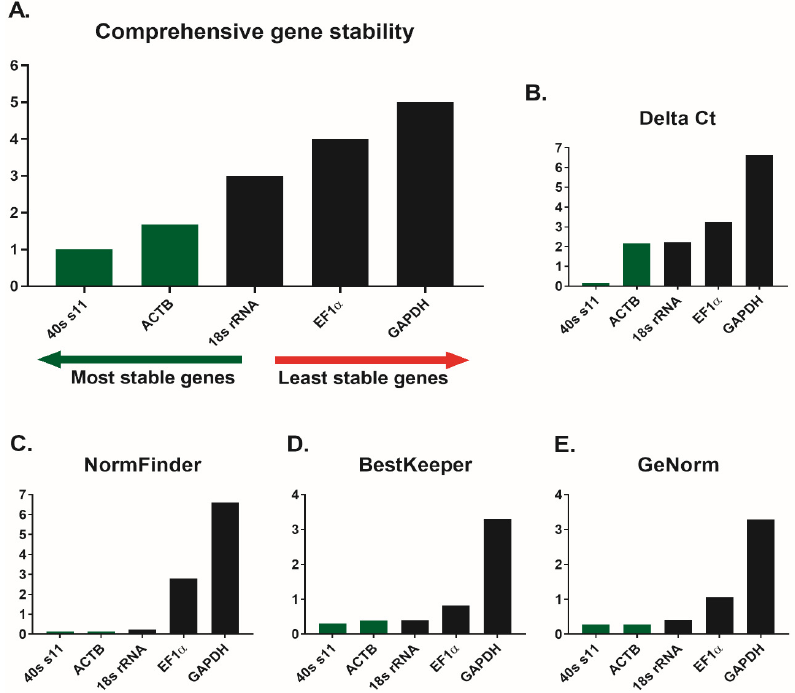
Figure 1. Analyses of the candidate reference genes for gene expression study in skin mucosa of common carp ( Cyprinus carpio ) using di ff erent algorithms: ( A ) comprehensive gene stability, ( B ) Delta Ct, ( C ) Normfinder, ( D ) BestKeeper, and ( E ) GeNorm. Candidate reference genes: Beta-actin (ACTB), Elongation factor 1-alpha (EF-1 α ), Glyceraldehyde-3-phosphate dehydrogenase-like (GAPDH),